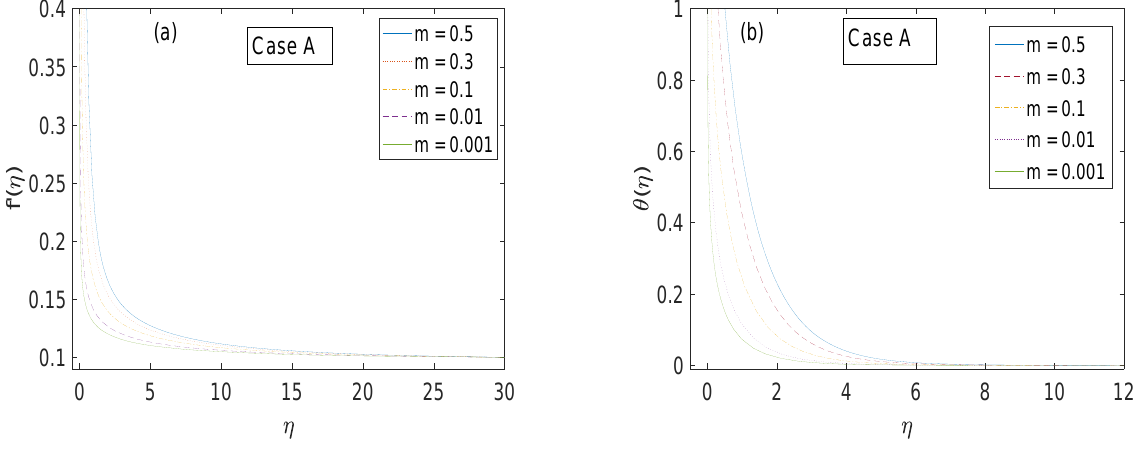
Figure 7. Axial velocity and temperature profiles for different values of parameter 𝜃 (cid:3032) when 𝜆 (cid:3404) 0.8 , Pr (cid:3404) 5 , 𝑚 (cid:3404) 0.1 and 𝜖 (cid:3404) 0.5 . Part ( a ) shows function 𝑓′ , while 𝜃 is plotted in part ( b ).